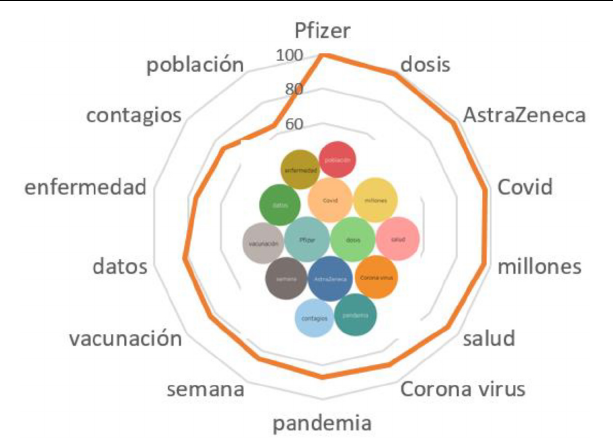
FIGURE 2 | Associative network of the stimulus Pfizer.